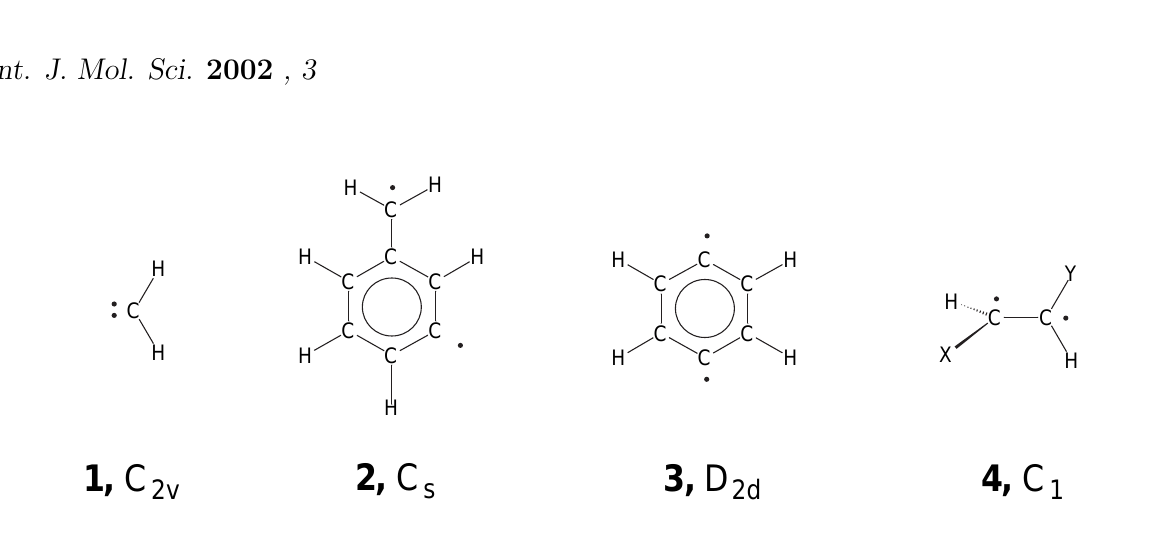
Scheme 1: Schematic representation of the molecules under discussion.